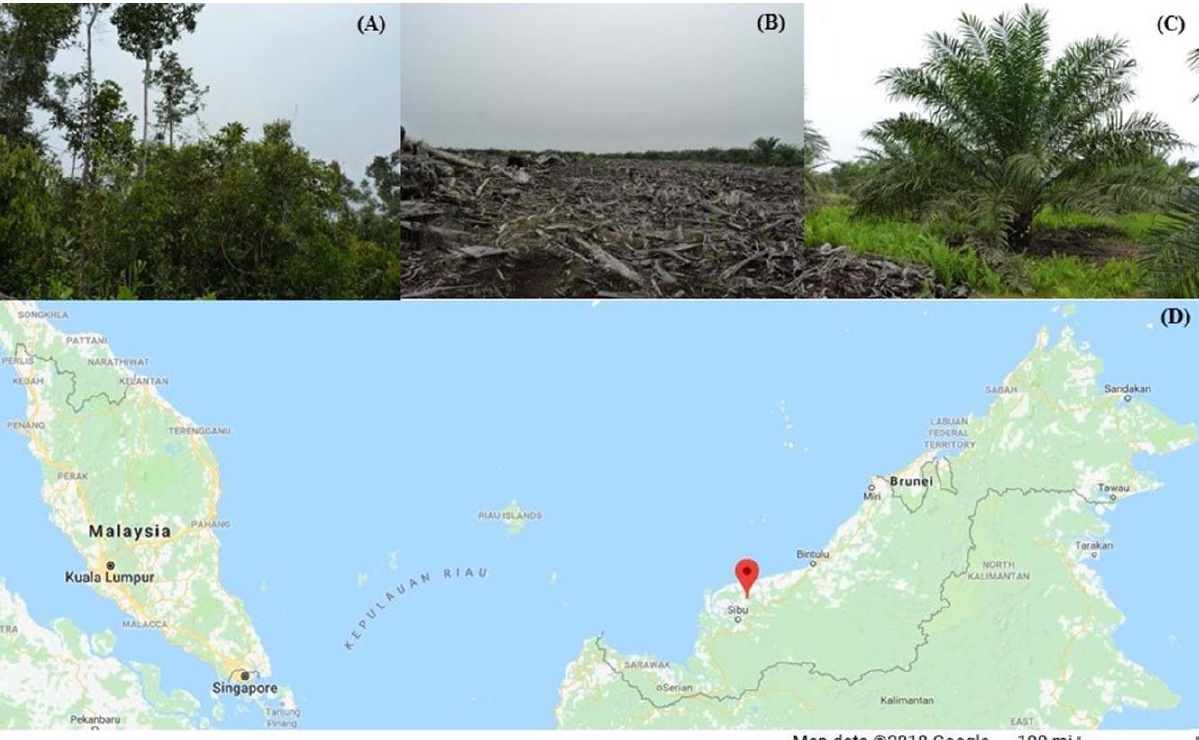
Figure 1. Example sampling sites in the three Alan Bunga peat swamp forest ecosystems: A) secondary forest (SF); B) logged-over secondary forest (LF); C) 3.5 YAP (years after planting) oil palm (OP); and D) map showing the location of the study near Sibu, Sarawak,